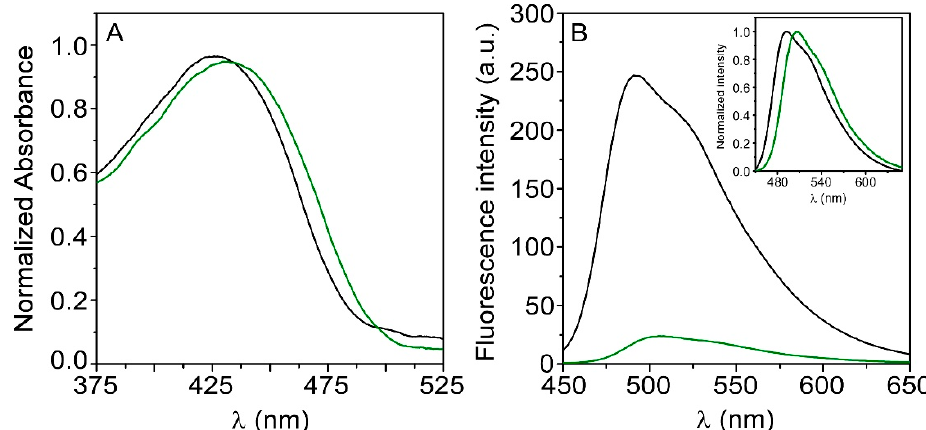
Figure 2. ( A ) Normalized Absorption spectra of HTMA-PFBT (3.1 µM in terms of repeat unit) in ethanol (black) and buffer (green). ( B ) Fluorescence emission spectra of HTMA-PFBT (1.5 µM) in ethanol (black) and buffer (green). Inset: Normalized fluorescence emission spectra of HTMA-PFBT in ethanol (black) and buffer (green). ( λ exc = 425 nm). Table 1. Absorption, fluorescence characterization and hydrodynamic diameter of HTMA-PFBT in ethanol, buffer, Large Unilamelar Vesicles (LUVs) of phosphatidylglycerol (PG) and LUVs of phosphatidylcholine